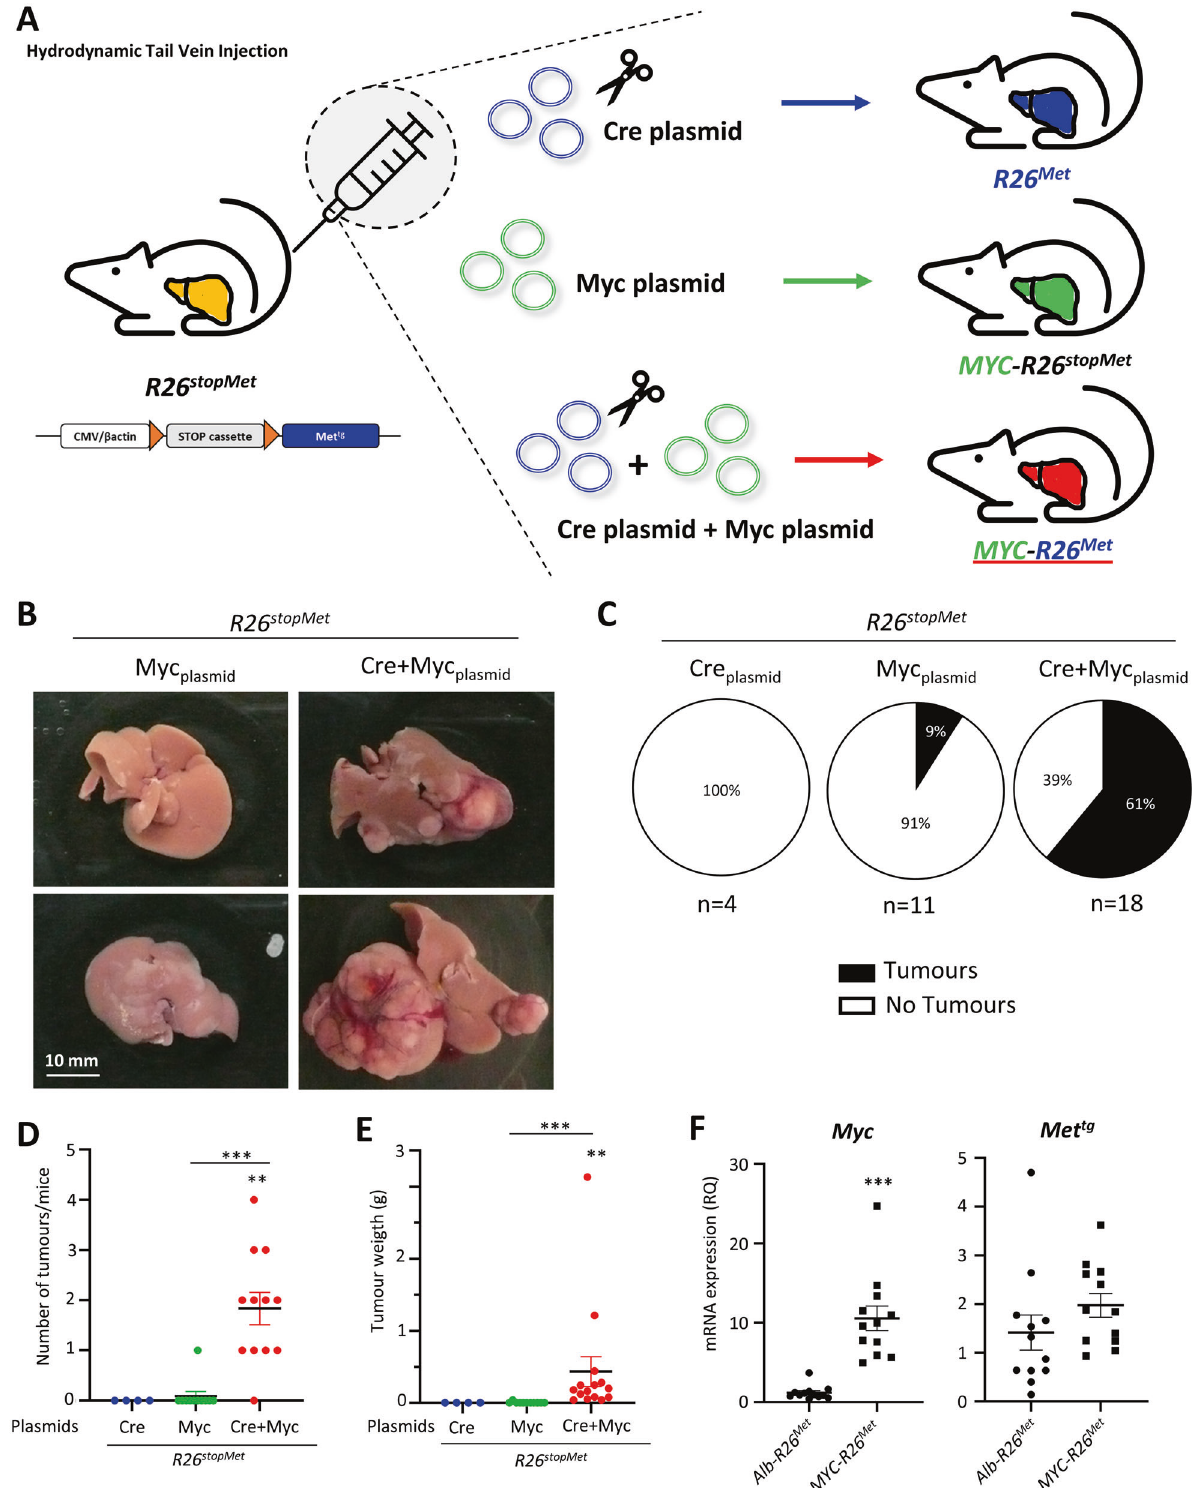
Fig. 2 Concomitant upregulation of MYC and MET in a subset of hepatocytes triggers tumorigenesis in mice. A Scheme illustrating the protocol of hydrodynamic tail vein injection used in R26 stopMet mice with Cre , Myc , or Cre + Myc plasmids. B Liver representative photographs of hydrodynamically injected R26 stopMet mice with Myc or Cre + Myc plasmids. C Pie charts representing the percentage of R26 stopMet mice with or without tumours (black and white, respectively) after hydrodynamic injection of Cre , Myc , or Cre + Myc plasmids. D , E Dot plots representing the number of tumours per mouse ( D ) and the tumour weight ( E ) in R26 stopMet mice hydrodynamically injected with Cre , Myc , or Cre + Myc plasmids. F Dot plots reporting the mRNA expression levels of Myc and Met tg analysed by RT-qPCR in dissected Alb-R26 Met and Myc-R26 Met tumours, normalised using the Gapdh housekeeping gene and expressed as RQ. Statistical analyses were performed by Mann – Whitney. * p ≤ 0.05; ** p ≤ 0.01; *** p ≤ 0.001. Cell Death and Disease (2022)